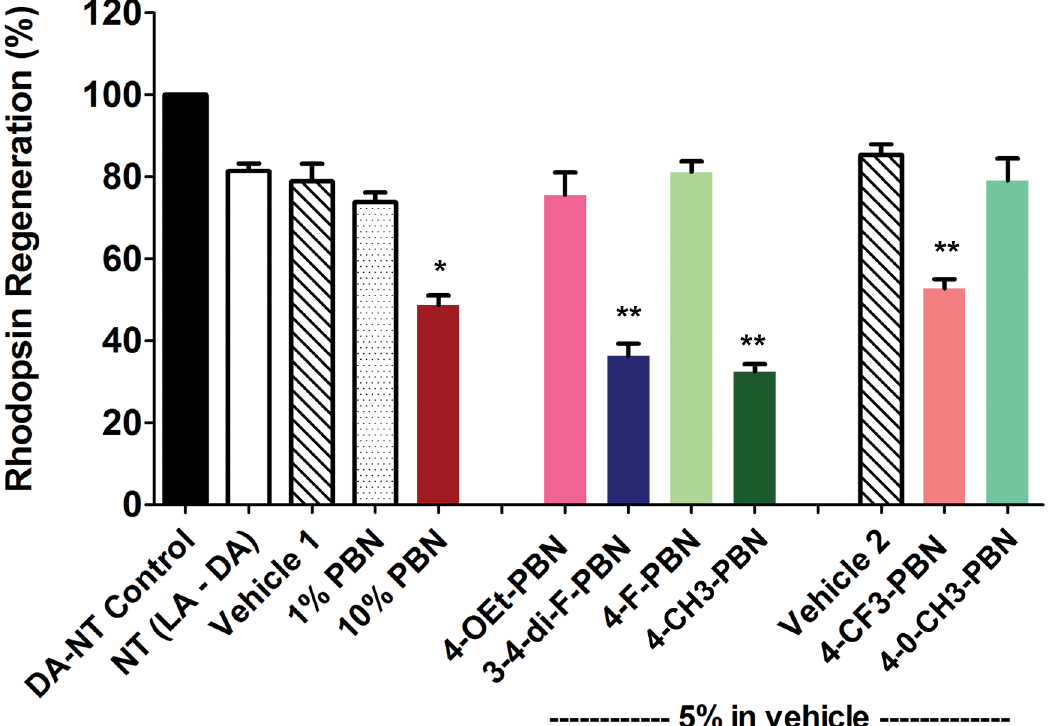
Fig 5. Mice treated topically with PBN or PBND ’ s showed reduction in rhodopsin regeneration. Dark adapted no treatment (DA-NT), no treatment light- adapted followed by dark adapted (NT LA-DA), and vehicle controls were used. Both 1% and 10% PBN were tested against 5% concentrations of PBNDs. Topical administration of assigned drug consisted of 1 drop in each eye once every 3 hours over a 6 hour period resulting in 3 total applications in light adapted mice eyes. Immediately following the 3 rd and final dose mice were placed in the dark for 1h before harvest. LA, light adapted; DA, dark adapted. [ * = p < 0.01; ** = p < 0.001; n =